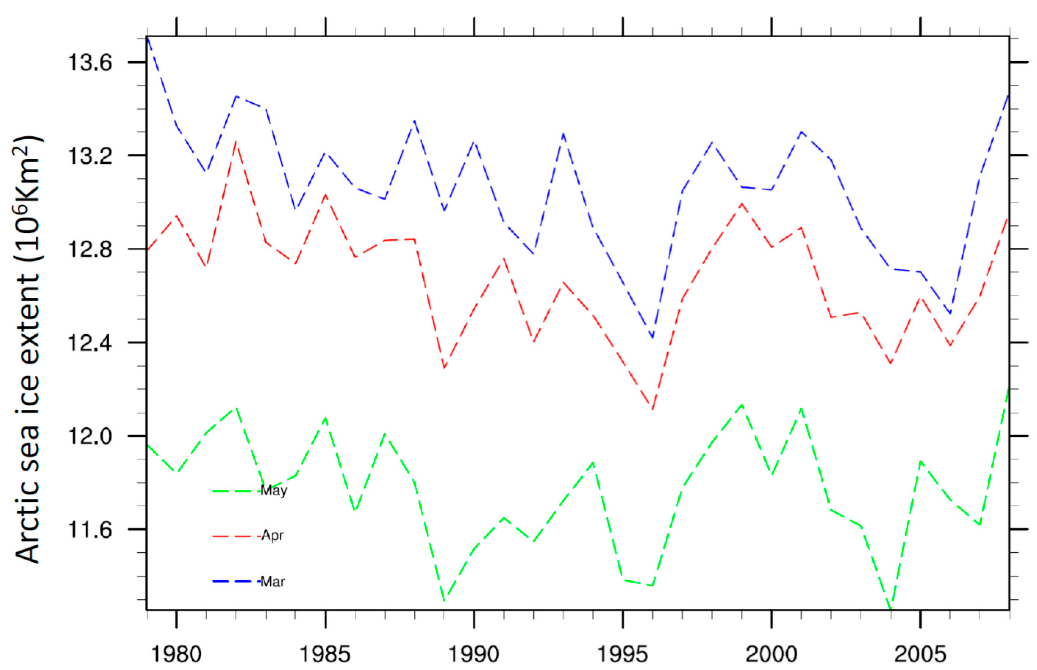
Figure 1. Monthly time series of Arctic sea-ice extent from 1979 to 2008 from monthly sea-ice concentration datasets prepared for CAM.